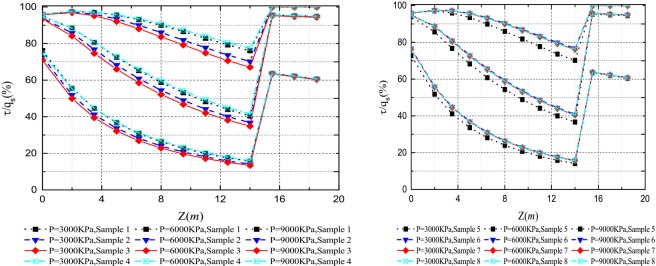
Effect of the samples on τ/qs-z curves.